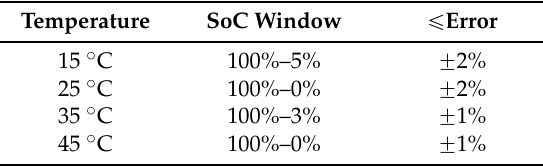
Figure 19. 2nd order Thévenin model measured and simulated worldwide harmonized light vehicle test procedure (WLTC) comparison at 25 °C with Coulomb counting and advanced characterization.